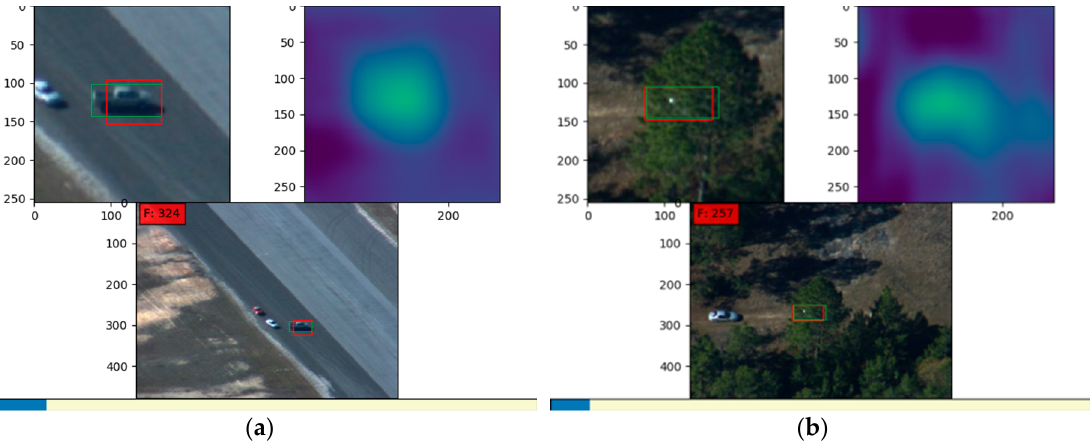
Figure 7. Results during ( a ) deformation and ( b ) occlusion. Bottom, tracking result in origin frame; top left, cropped image showing partial enlarged detail of tracking result; top right, corresponding heat map denoting similarity. Green boxes, ground truth; red, tracking results.